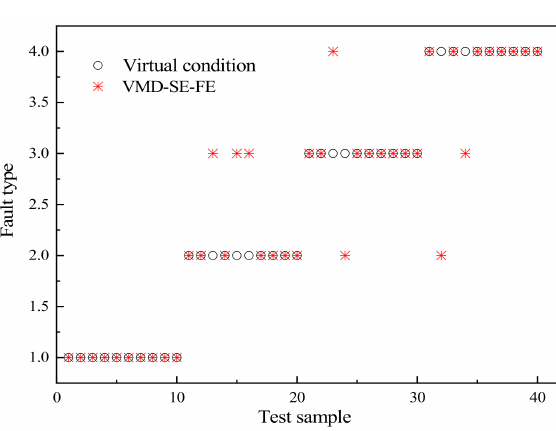
Figure 4. Prediction results of kernel extreme learning machine model based on VMD-FE+SE.